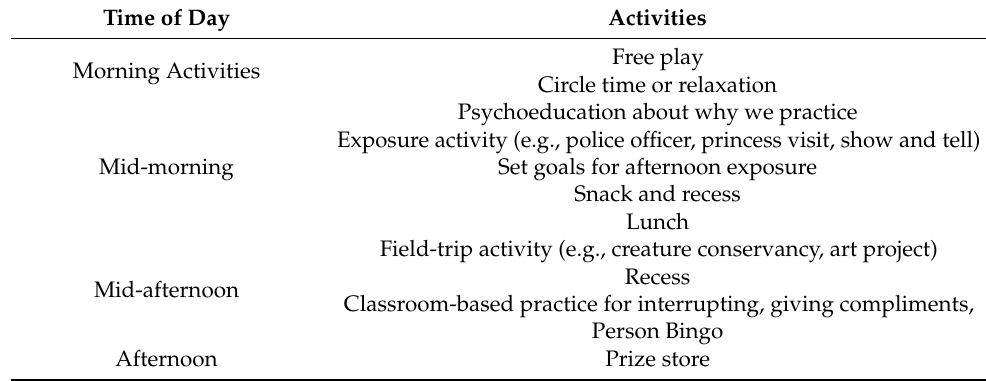
Table 1. Confident Kids Camp Daily